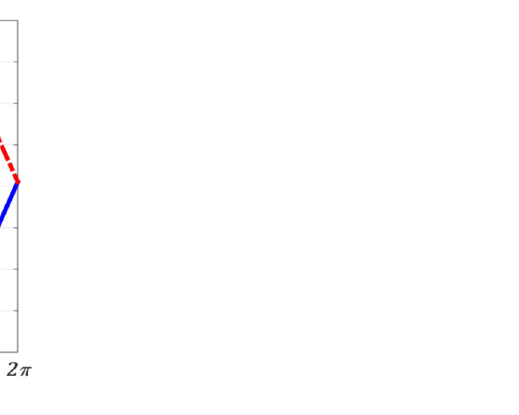
0.2, γ 0.02, eV b = =